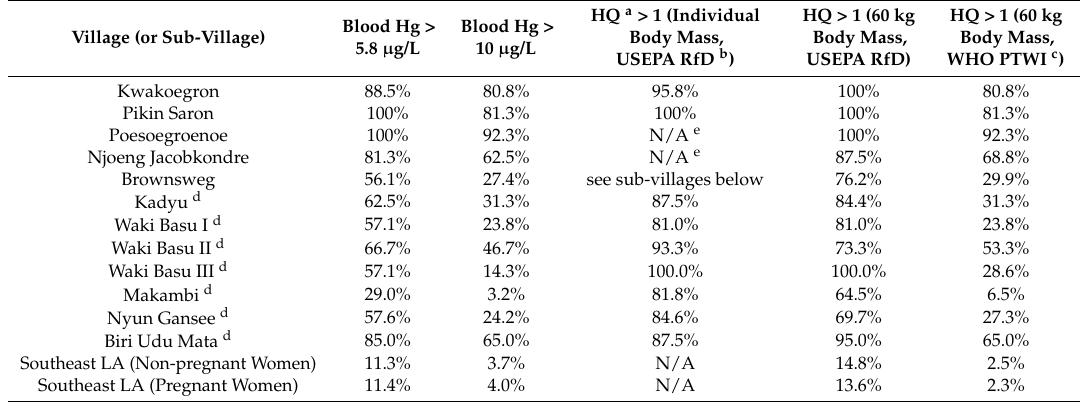
Table 2. Percentages of participants with estimated blood levels exceeding safe thresholds and hazard quotients according to US Environmental Protection Agency USEPA or WHO criteria.